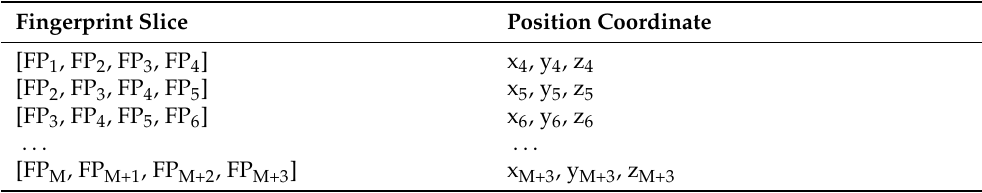
Table 3. Fingerprint slice